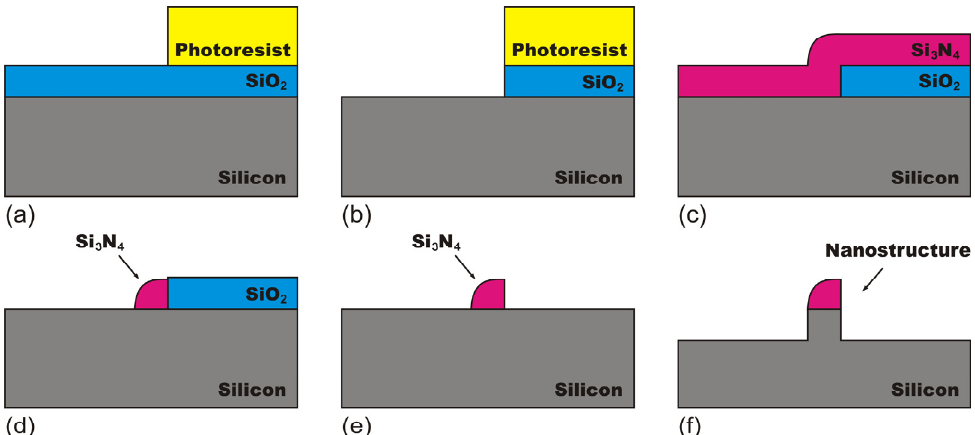
Figure 3. Schematic process of the side wall deposition and etch-back technique. ( a ) The photoresist is structured by conventional photolithography and ( b ) transferred to the underneath SiO 2 layer. ( c ) Subsequent to the photoresist removal, Si 3 N 4 is deposited conformably and ( d ) etched back by a directional dry etching process. ( e ) The SiO 2 layer is removed by selective wet etching and a Si 3 N 4 spacer stays on the surface. ( f ) Applying the spacers as a mask, the structure can be transferred to the underneath layer.